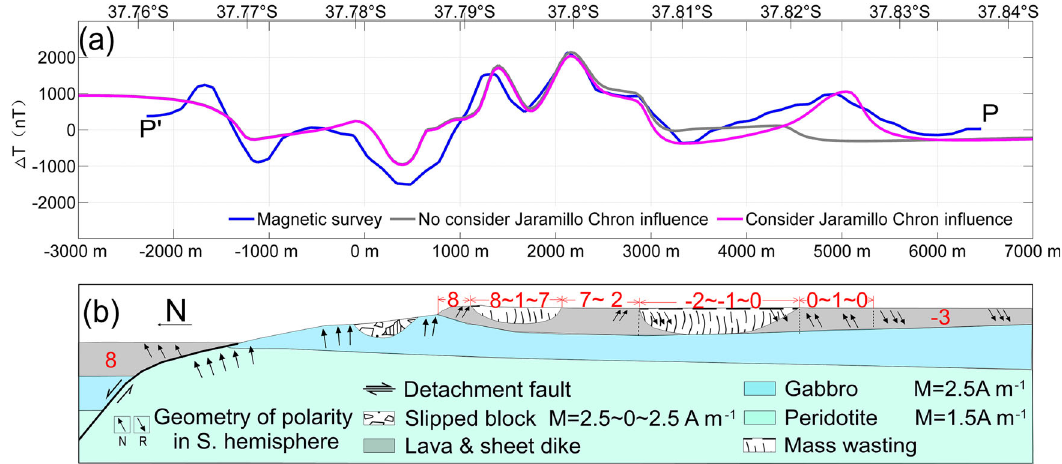
Fig. 5 A comparison of forward magnetic modeling results based on 2-D magnetic models. a Forward magnetic modeling results. b 2-D magnetic models with the observed near-bottom magnetic pro fi le PP ′ (marked by bold blue line in a ). We assumed that the effective magnetic layer thickness is 1 km, that the footwall rotated about 21.2° based on the present faulting surface slope angle, and that the rotation angle progressively increases with the distance from the termination. Red-colored numbers are magnetizations (in A m − 1 ) based on sample measurements (see Supplementary Table 1), where minus means reverse polarity. The mass wasting magnetization value of zero reduces the effective layer magnetization contribution. Geomagnetic reversals are modeled as vertical boundaries for simplicity and the GAD inclination (62.3°) is used except for the area changing with footwall